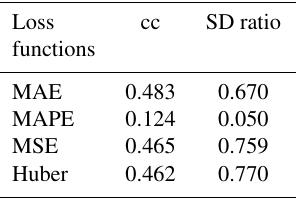
Table B1. Different loss functions conditioned using other fixed parameters (two hidden layers, 4000 hidden nodes, and learning rate of 10 − 3 , using the Leaky ReLu activation function and a batch size of 20).